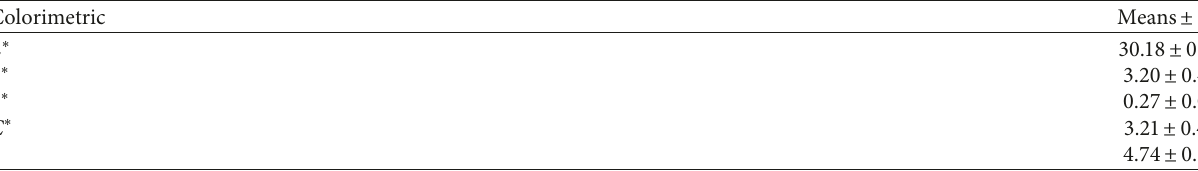
Table 3: Colorimetric characterization of Shiraz grape